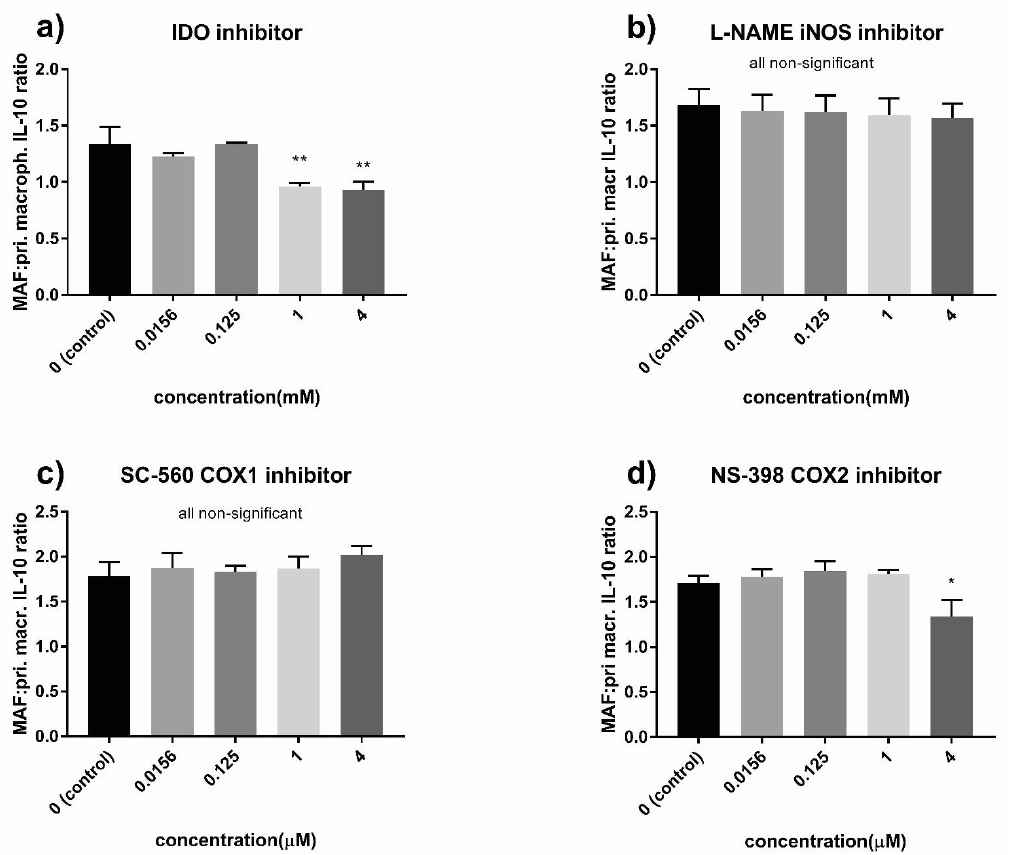
Figure 10. Inhibitors of IL-10 production in MAFs/primary macrophages co-culture. Ratio of IL-10 concentration of MAF/primary macrophage co-cultures to primary macrophage monocultures treated with different concentrations of 1-methyl-d-tryptophan (IDO inhibitor) ( a ), NG-nitro-L-arginine methyl ester (L-NAME) iNOS inhibitor ( b ), SC-560 COX1 inhibitor ( c ), and NS-398 COX2 inhibitor ( d ), n = 3. Error bars represent means ± s.e.m. * p < 0.05 and ** p < 0.005. pri. macr.: primary macrophage.